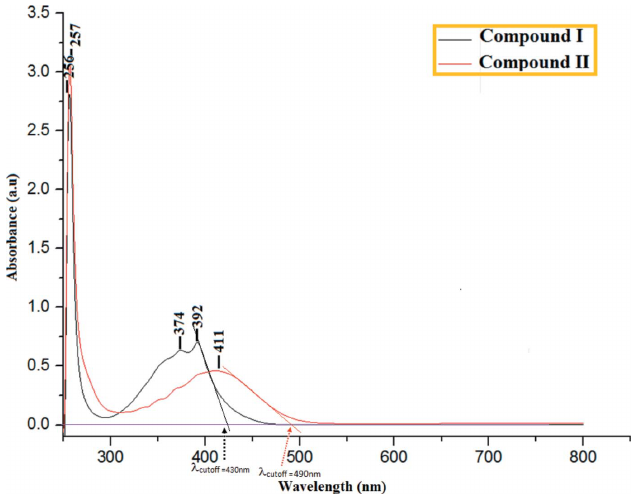
Figure 3 The UV–vis absorption spectra of compounds (I) and (II). For the extrapolation lines, see